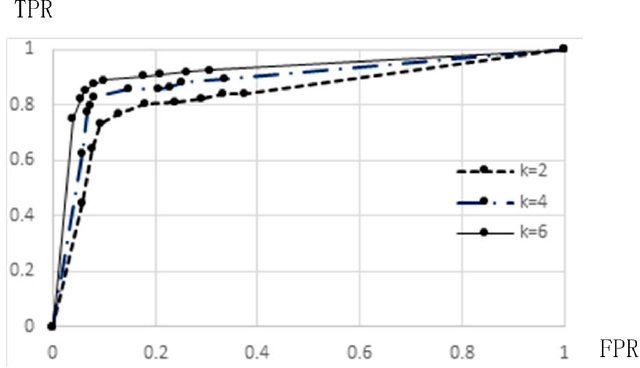
Figure 8. ROC curve of the Mahalanobis distance method with different k values.